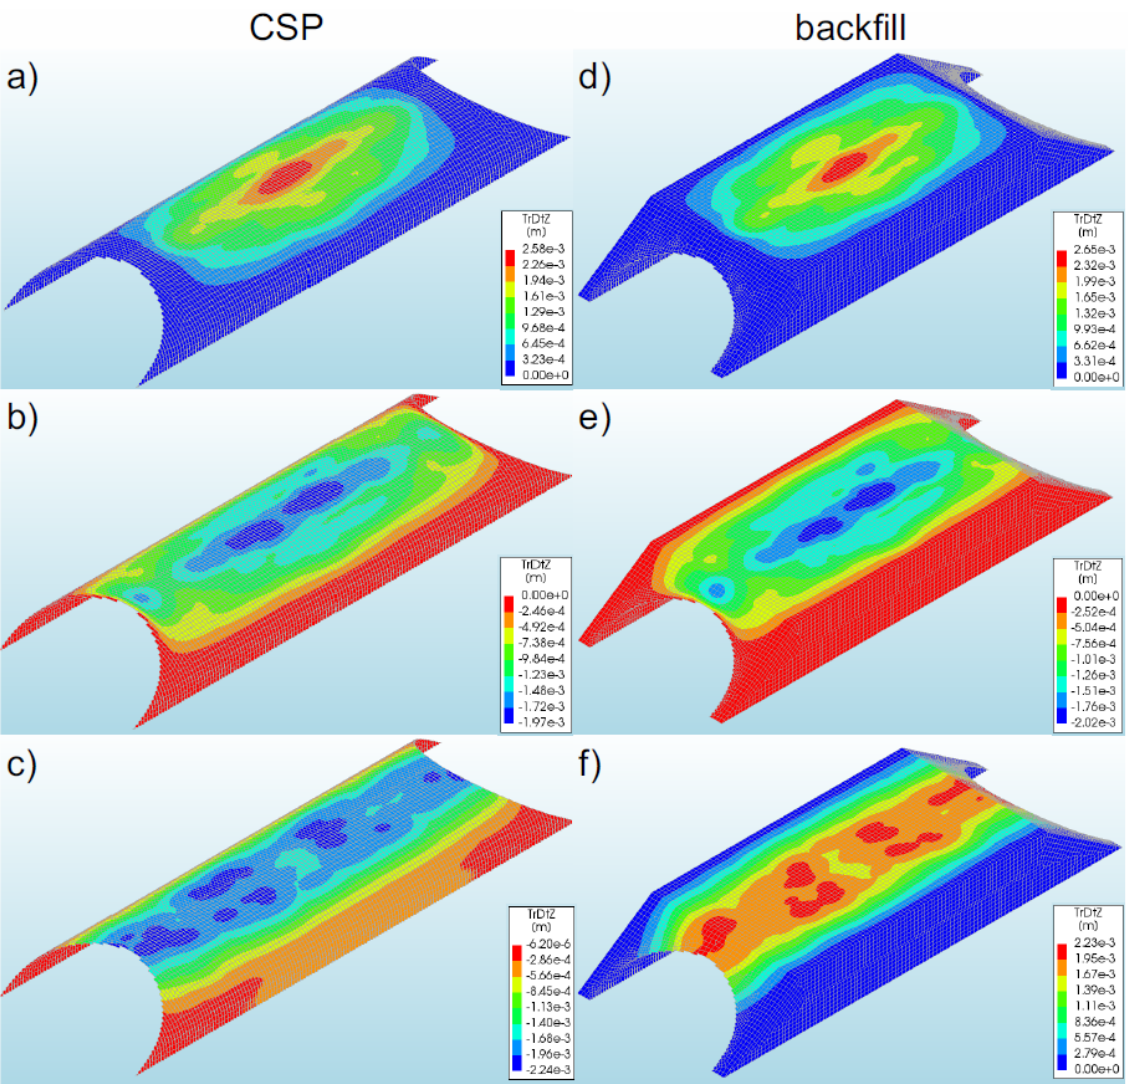
Figure 12. Maximum vertical displacements of the shell and backfill for bridge #I in model 1 ( a , d ), model 2 ( b , e ), and model 3 ( c , f ).